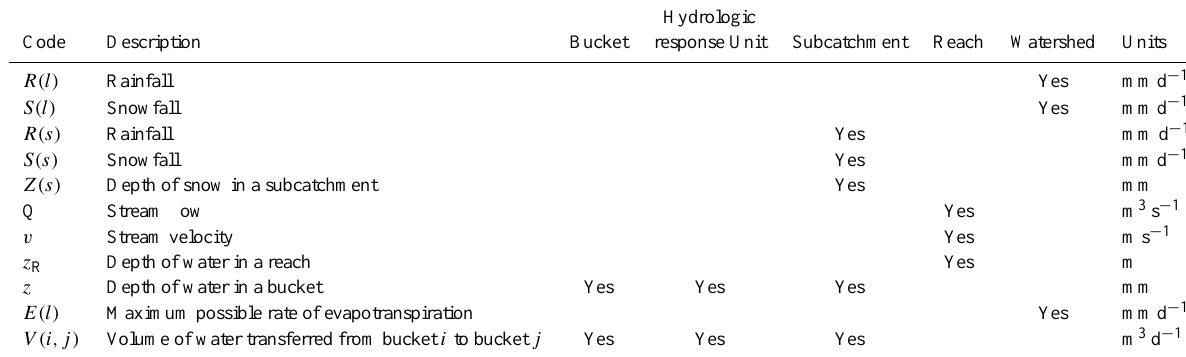
Table 3. PERSiST Internal Time